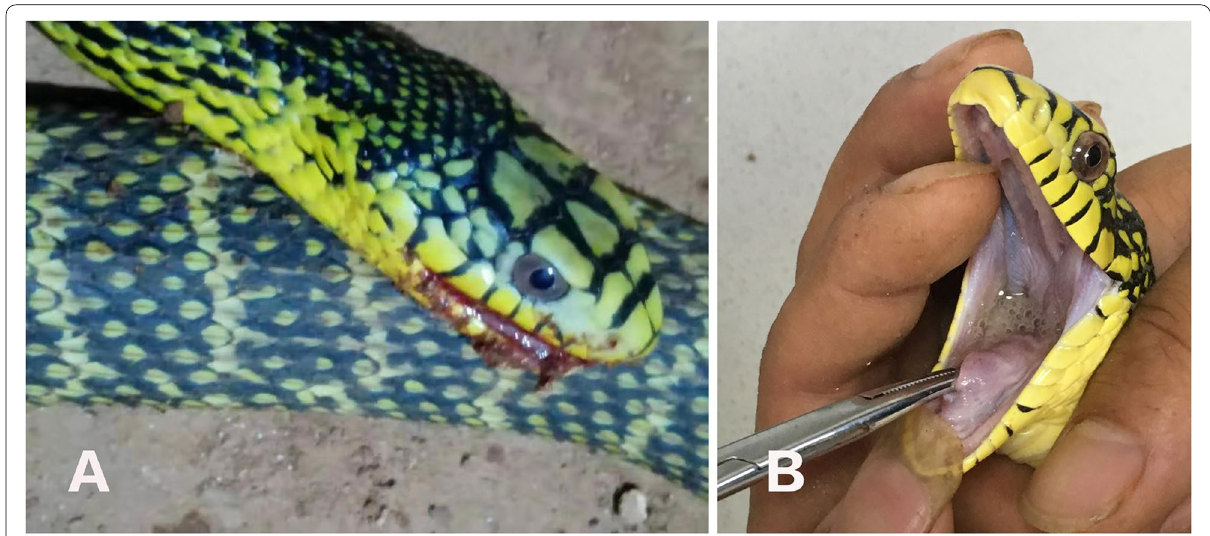
Fig. 1 Clinical signs. A Hematemesis for more severely infected snakes; B Full mouth of greenish purulent secretion during